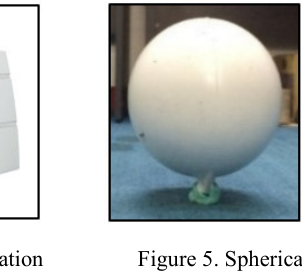
Figure 5. Spherical target used in this